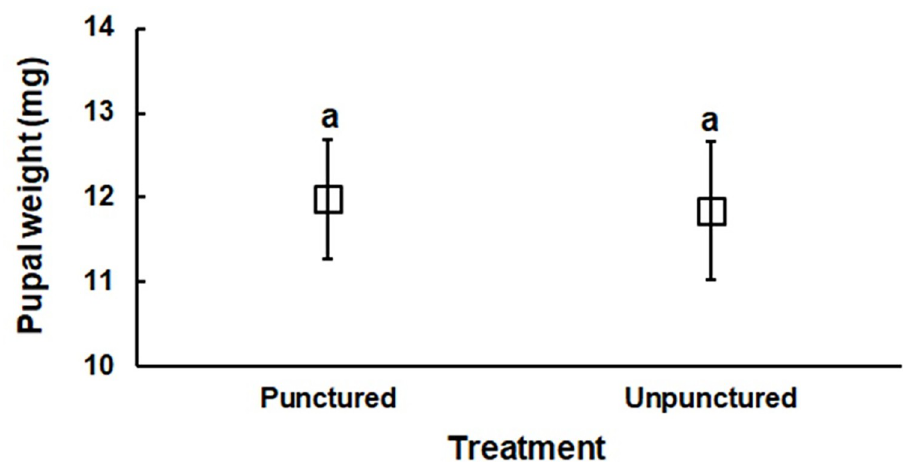
Fig 2. Pupal weights of Grapholita molesta reared on punctured and unpunctured apples.